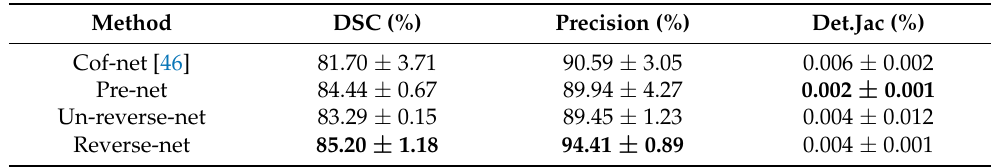
Table 1. Quantitative results of ablation experiments. The numbers following the ± indicate the standard